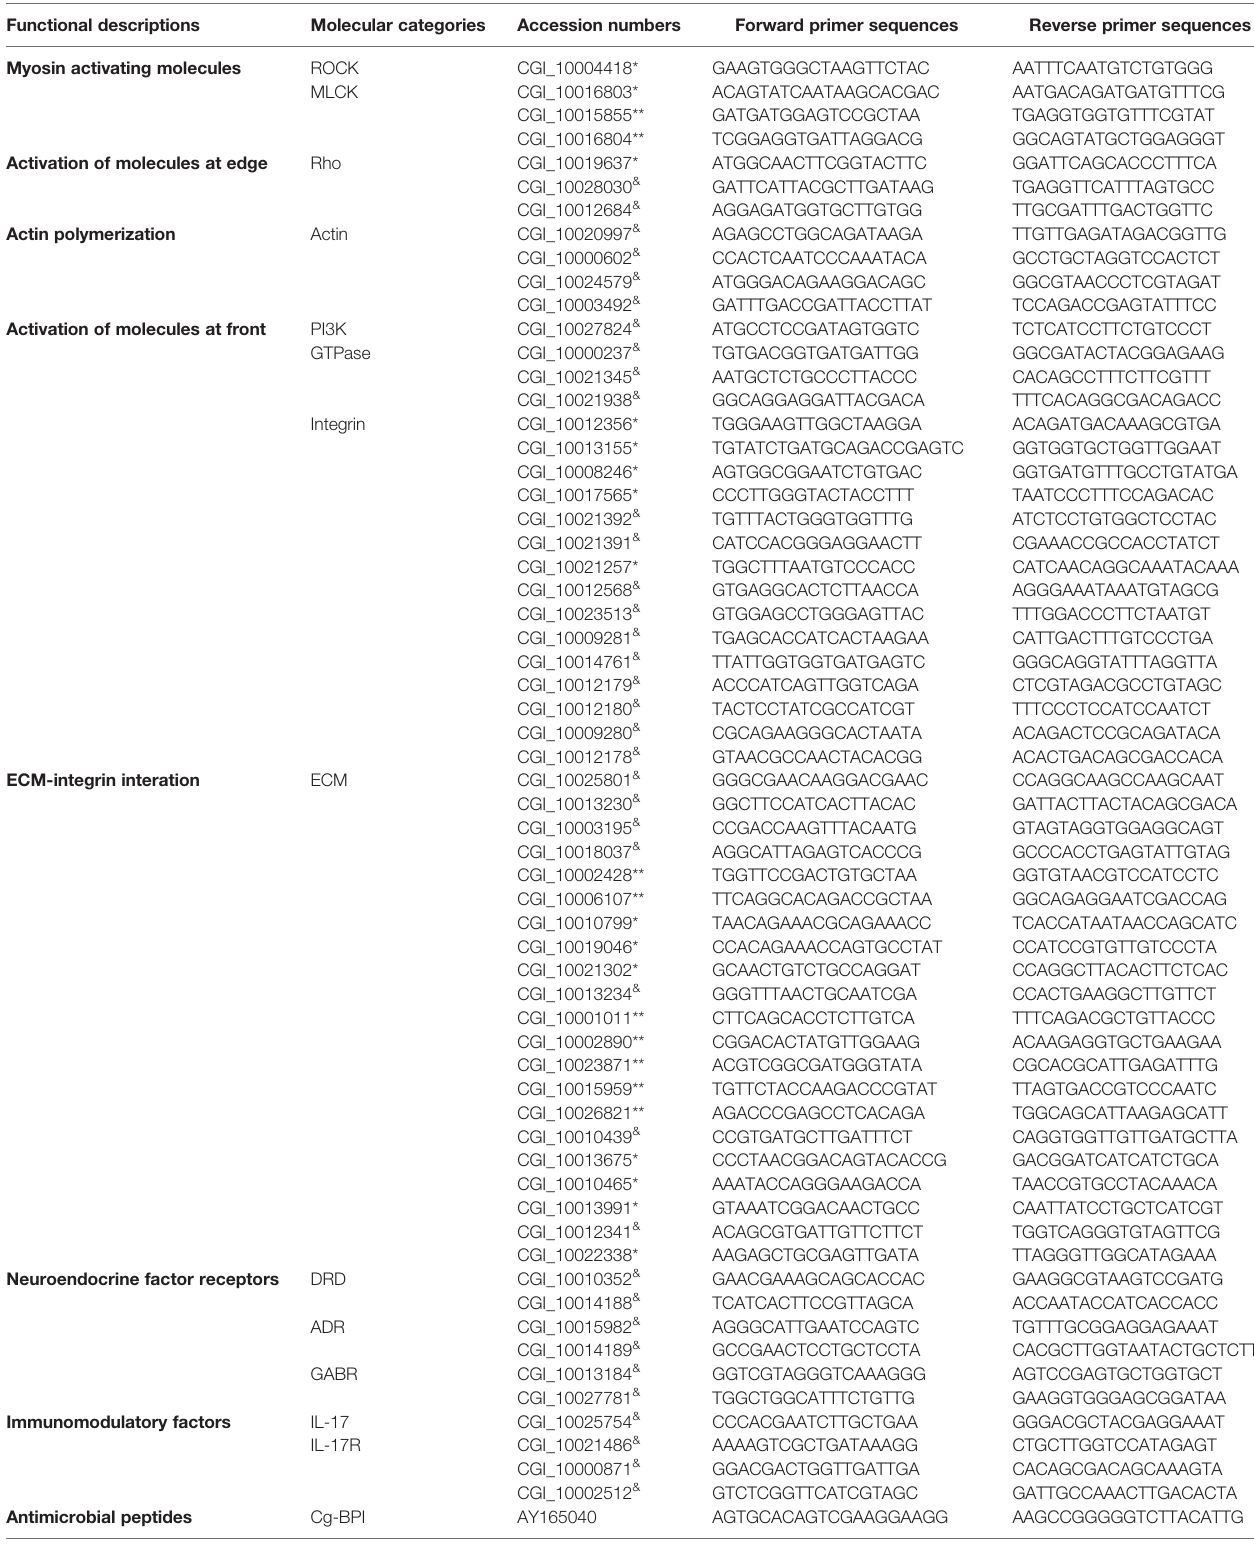
TABLE 1 | The information of representative DEGs associated with hemocytes migration, neuroendocrine regulation and immunomodulatory, and AMP genes for qPCR